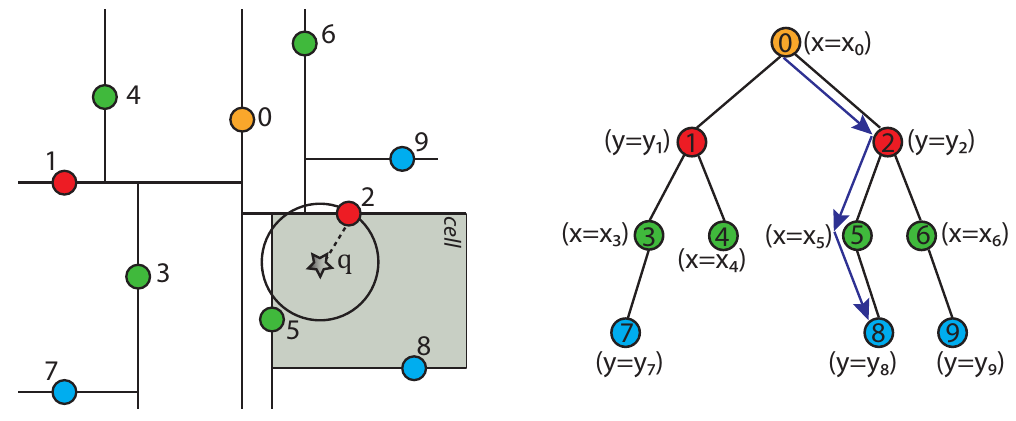
Figure 11. A fully constructed k-d tree and its tree